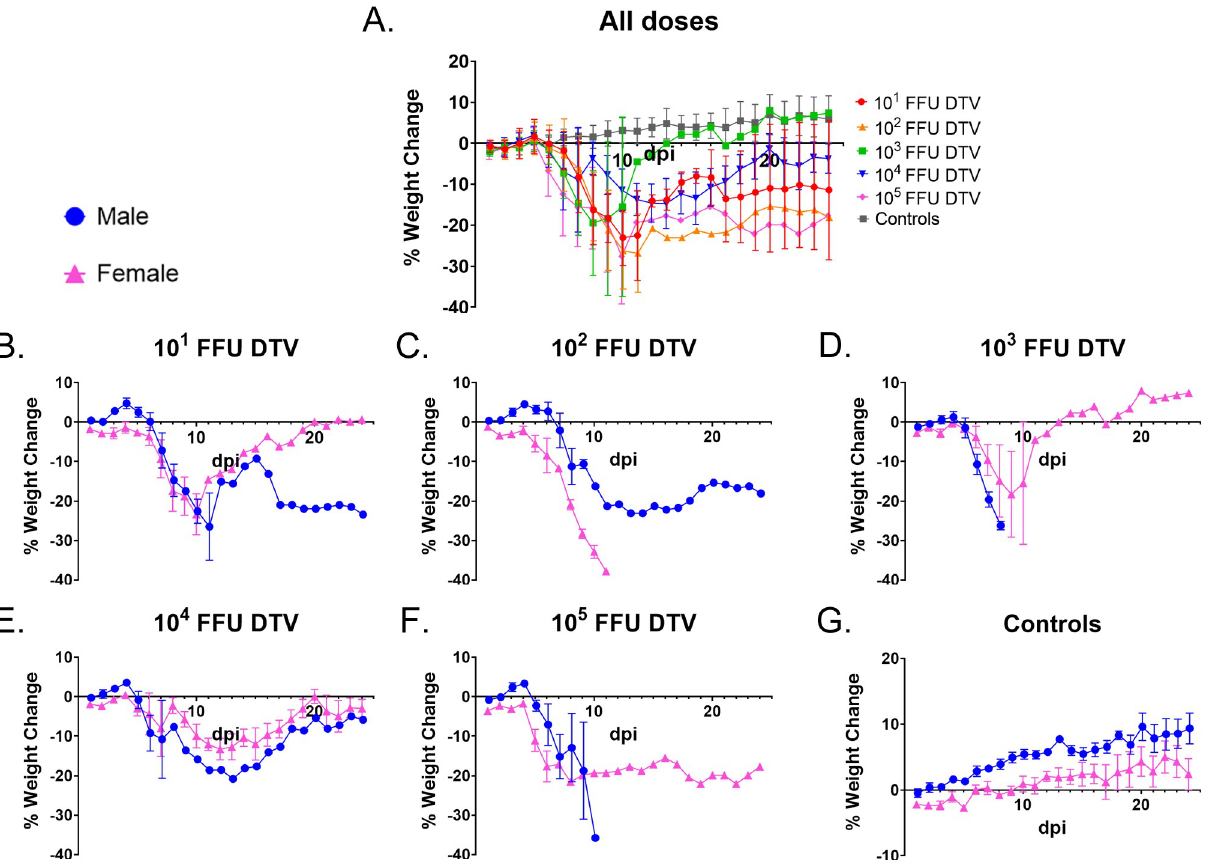
Fig 2. Weight loss for DTV-infected mice. Mice were weighed daily, and weights are expressed as percentage of initial body weight prior to infection (study day 0). A ) Weight change curves for each infection dose cohort (n = 8). B–G ) Weight was monitored daily for male (n = 4) and female (n = 4) mice inoculated with B ) 10 1 FFU DTV, C ) 10 2 FFU DTV, D ) 10 3 FFU DTV, E ) 10 4 FFU DTV, F ) 10 5 FFU DTV, or G ) media. Error bars represent standard error of the mean